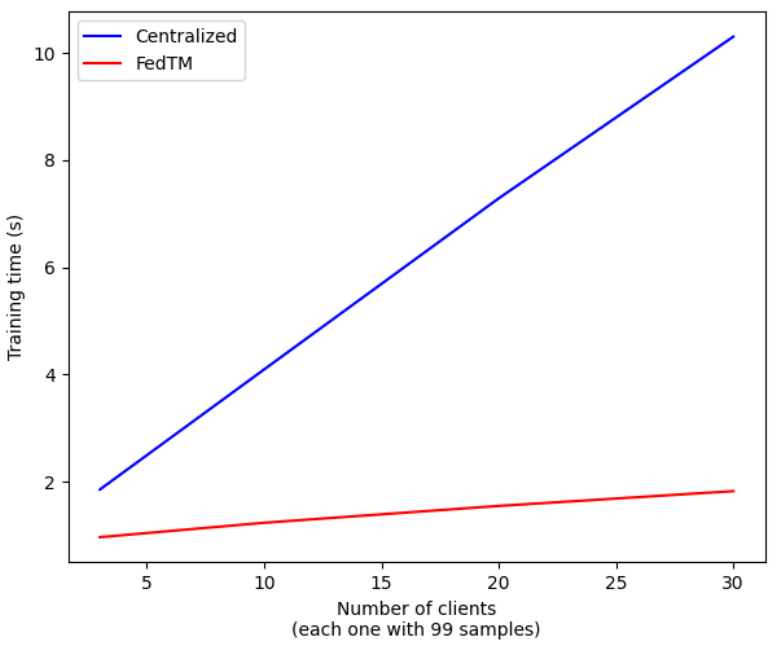
Figure 8. Training time for a growing number of